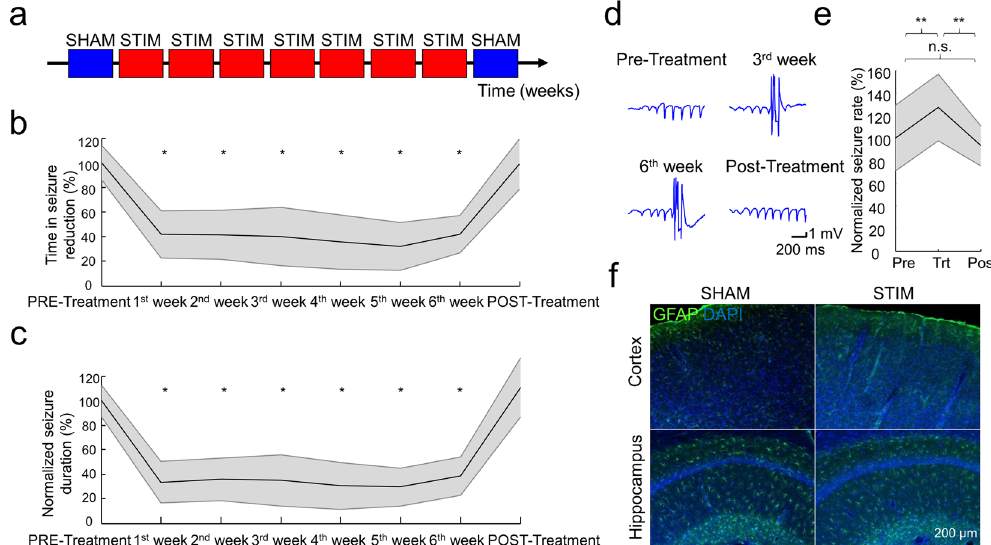
Figure 4. Results of the seizure suppression during the long-term stimulation protocol. (a) Experimental timeline. ( b and c) Group data show the stable and similar decrease of Time in Seizure ( b ) and average seizure duration ( c ) as long as the closed-loop seizure suppression is on (each measure is normalized to its corresponding mean Pre-Treatment value for each animal). ( d) Example LFP traces of one representative rat demonstrating the recording quality over the weeks. Note that the amplitudes and signal to noise ratios are qualitatively similar, suggesting a negligible change of the electrode conductance. ( e) Group data show seizure rates before (Pre), during (Trt) and after (Post) the treatment (normalized to the average seizure rates during the Pre days for each animal). Shaded area represents ± SEM. ( f) Representative histological examples of cortical and hippocampal regions of control (SHAM) and long term treated (STIM) animals, stained for GFAP (green) and DAPI (blue). Note that stimulation did not induce overt gross histological changes (i.e. gliosis) despite the long-term application. * p < 0.001 , ** p < 0.05 vs Pre-Treatment , one-way ANOVA ( b,e ), Kruskal-Wallis test ( c ), both followed by post hoc HSD.